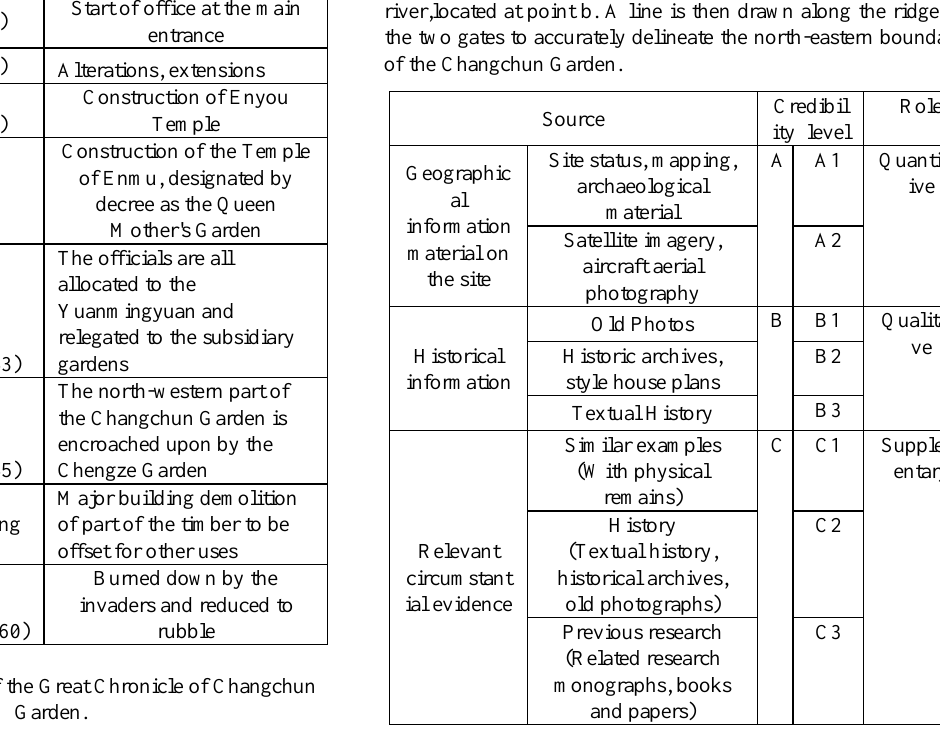
Table 2. Corresponding table of sources, credibility levels and